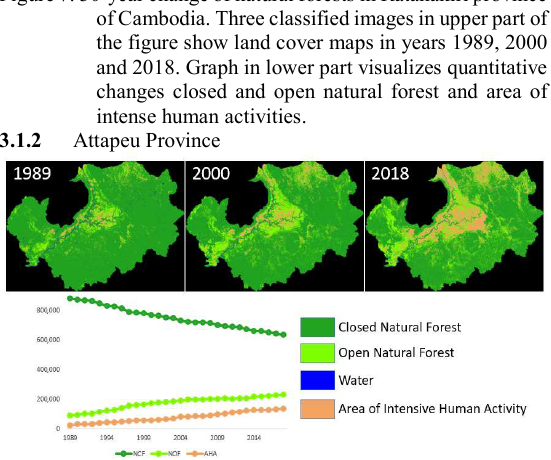
Figure 8. 30-year change of natural forests of Attapeu province of Laos. Three classified images in upper part of the figure show land cover maps in years 1989, 2000 and 2018. Graph in lower part visualizes quantitative changes closed and open natural forest and area of intense human activities.